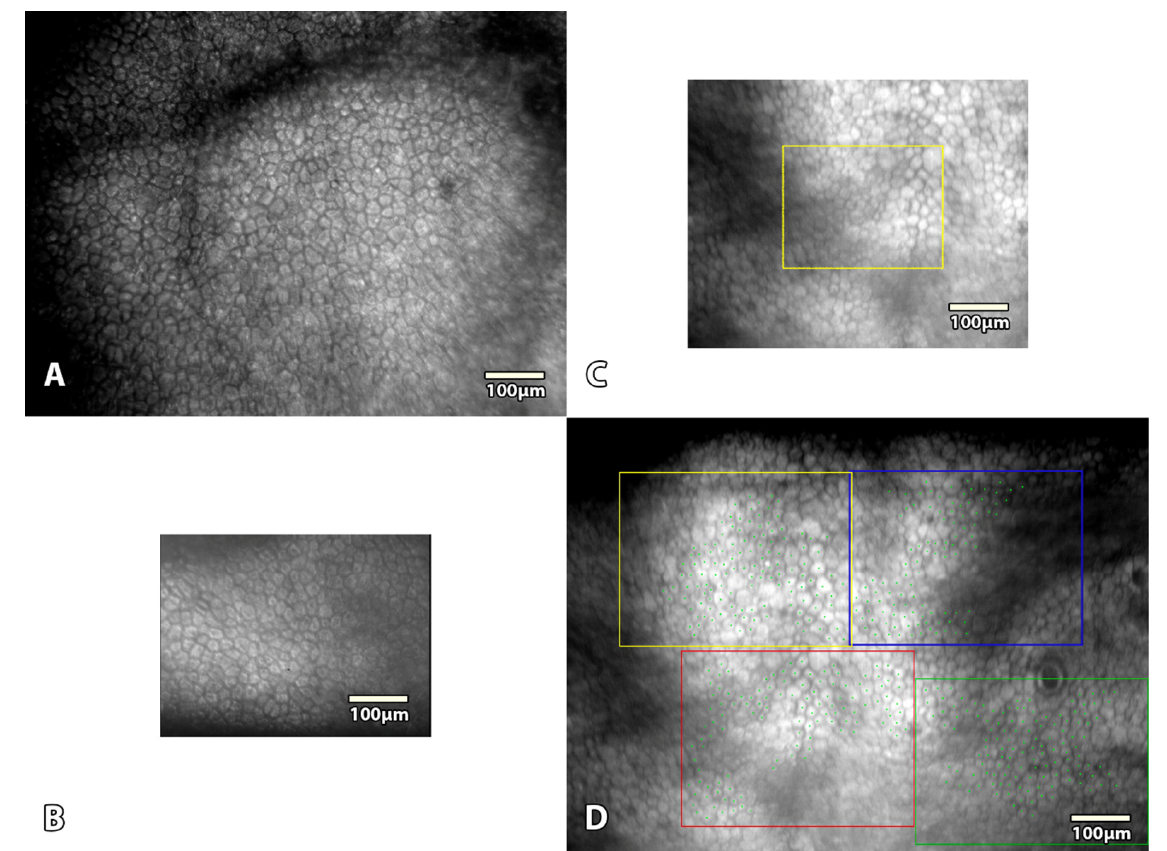
Figure 2. Comparison between our prototype and 3 eye banks’ specular microscopes (SM). ( A ) The custom-made prototype SM with 935 × 748 µ m and 1280 × 1024 pixels TIFF image. The entire surface could be analyzed. ( B ) The HAI EB-2000xyz had a 368 × 490 µ m field of view (480 × 640 pixels BMP image) and analysis (3.9 times smaller). ( C ) The KONAN EB-10 had a 480 × 600 µ m field of view (595 × 794 pixels BMP image) and a 280 × 200 µ m field of analysis (respectively 2.4 and 12.5 times smaller). ( D ) The KONAN Cell-ChekD(+) had a 1000 × 750 µ m field of view (1296 × 972 pixels BMP image) and up to 4 areas of 400 × 300 µ m field of analysis (respectively 1.1 times larger but 1.5 times